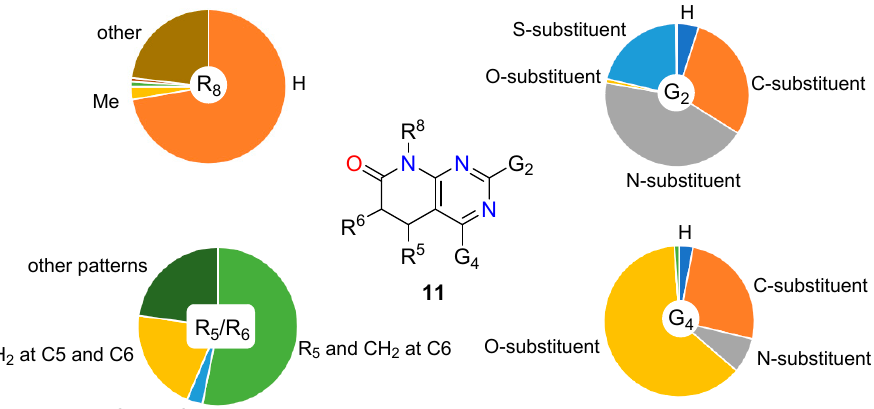
Figure 5. Diversity analysis of the substituents present at positions C2, C4, C5, C6, and N8 of 5,6-